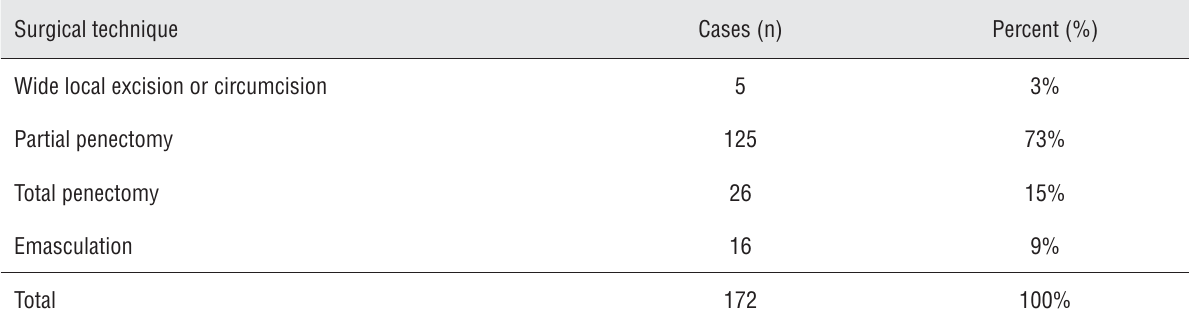
Surgical technique Cases